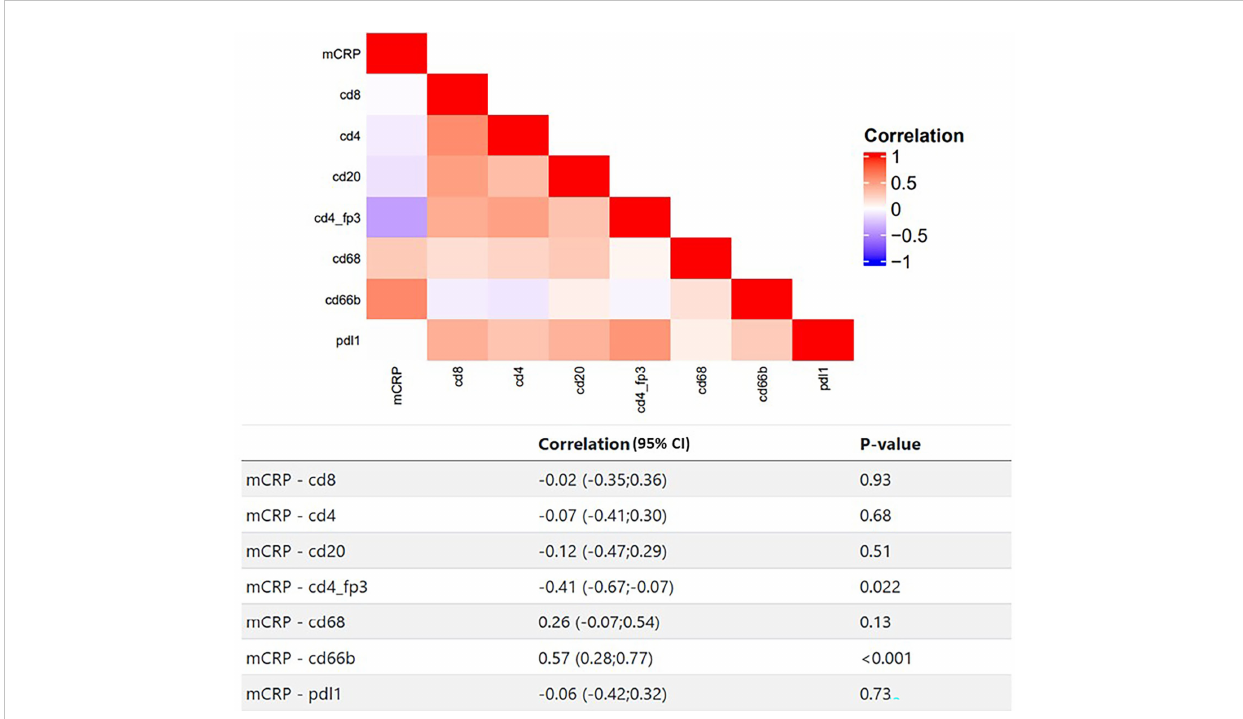
FIGURE 4 Correlating mCRP and selected adaptive and innate immune markers in colon cancer patients. Heatmap and corresponding table of Spearman correlations between mCRP and individual immune markers. Red color indicates positive correlation, blue indicates negative correlation, white indicates no